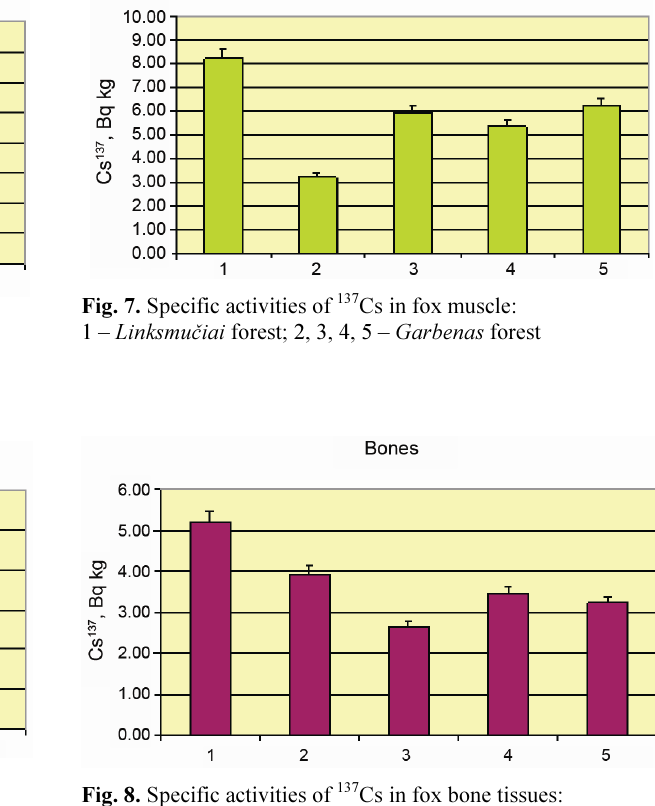
Fig. 8. Specific activities of